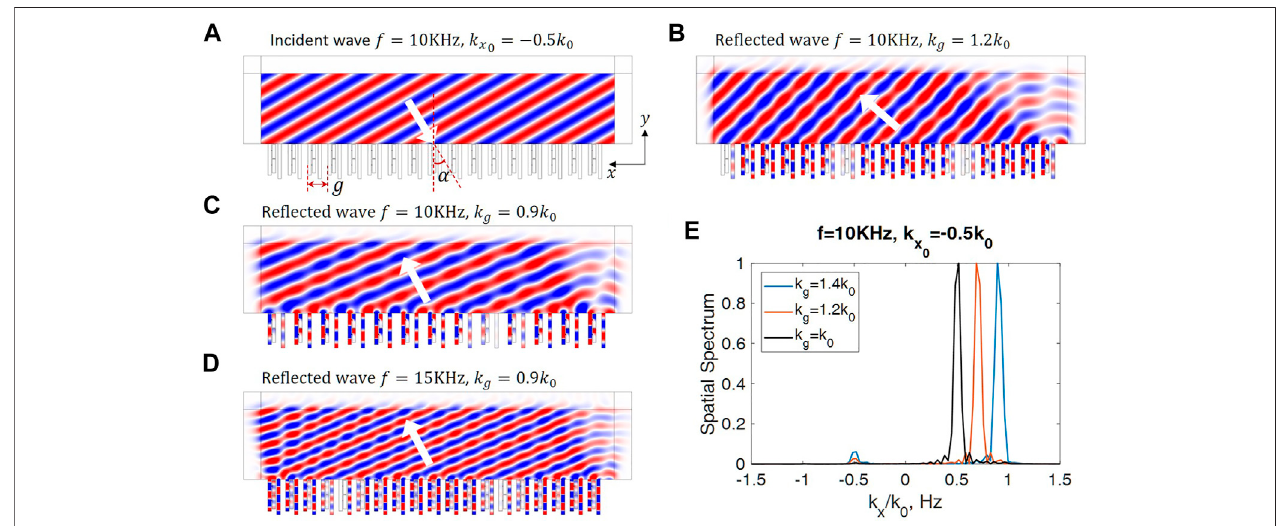
(cid:1) − 0 . 5 k – D) Re fl ected wave 0 (B 0